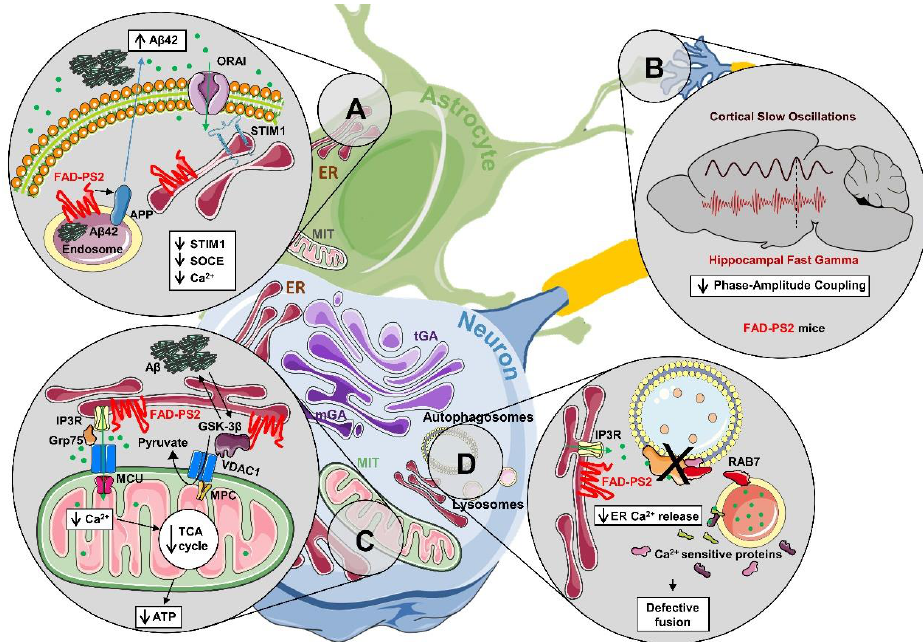
Figure 2. Functional consequences of dysregulated Ca 2 + signalling induced by FAD-PS2. The cartoon represents the major dysfunctions linked to the expression of FAD-PS2 mutants at both the cellular and brain network levels. ( A ) Decreased store-operated Ca 2 + entry (SOCE) potentiates amyloid precursor protein (APP) processing and A β 42 production. ( B ) FAD-PS2-N141I-based mice show altered neuronal circuits (decreased phase-amplitude coupling between cortical slow oscillations and hippocampal fast gamma frequencies). ( C ) Decreased mitochondrial Ca 2 + signalling and pyruvate uptake impair mitochondrial metabolism and cell bioenergetics. ( D ) Reduced endoplasmic reticulum (ER) Ca 2 + release blocks the recruitment to autophagosomes of the Ras-associated binding protein RAB7 and their subsequent fusion with lysosomes. See text for details.